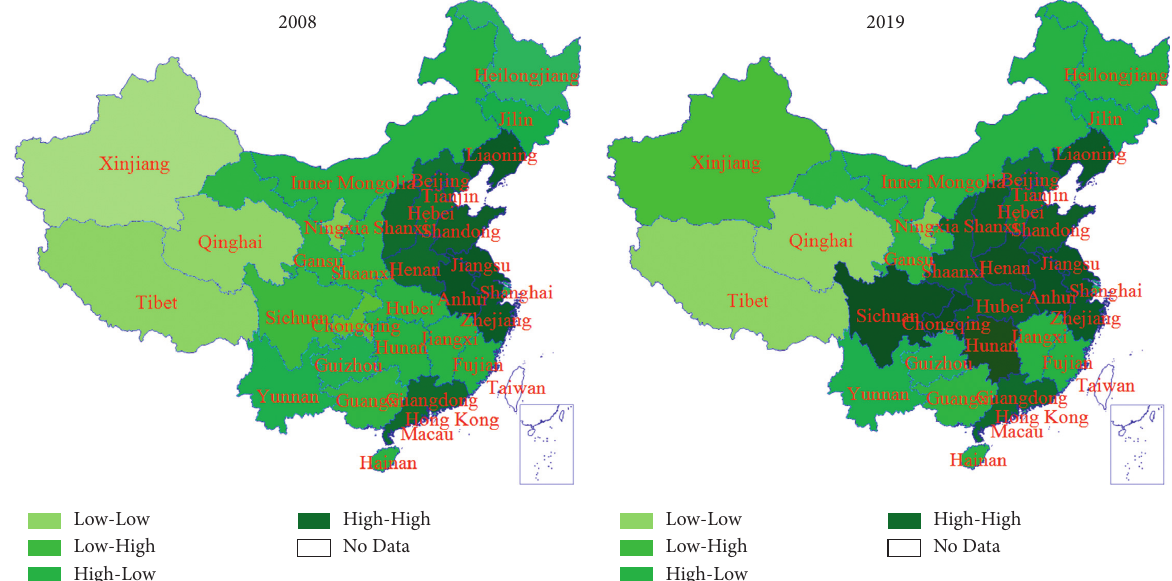
Figure 7: Regional agglomeration map of the ecological environment in various regions of China in 2008 and